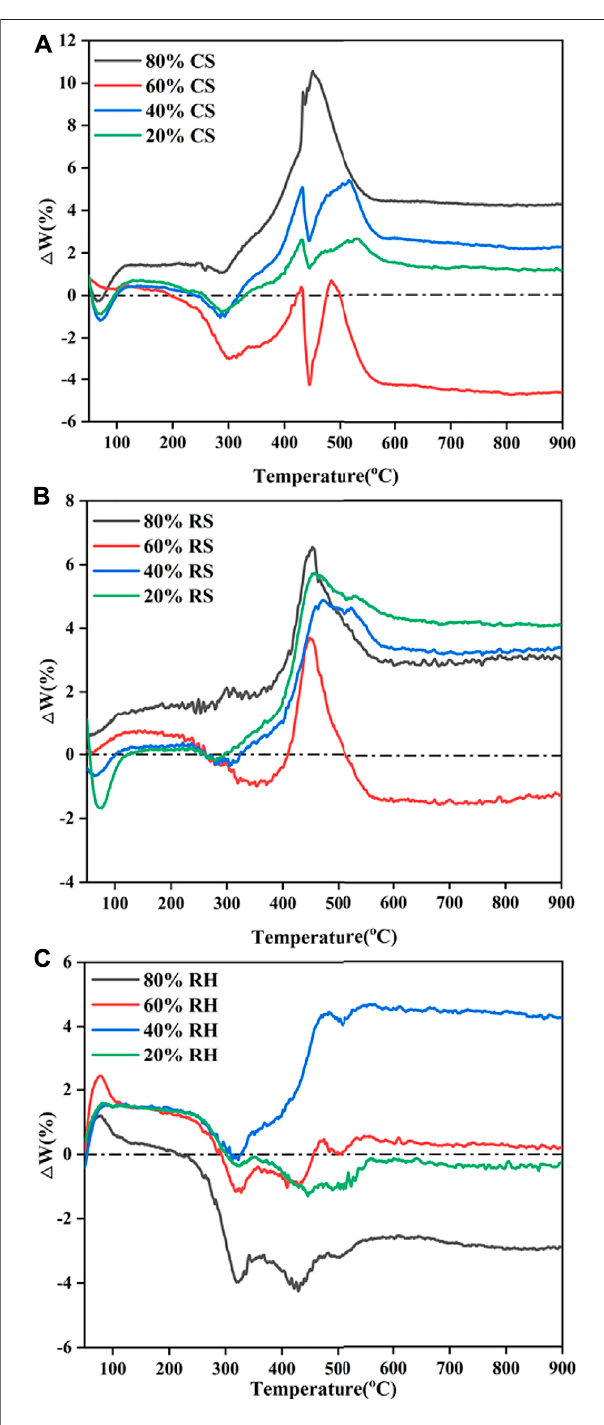
FIGURE 6 | Comparison of deviation between calculated and experimental TG values: (A) CS, (B) RS, and (C) RH.